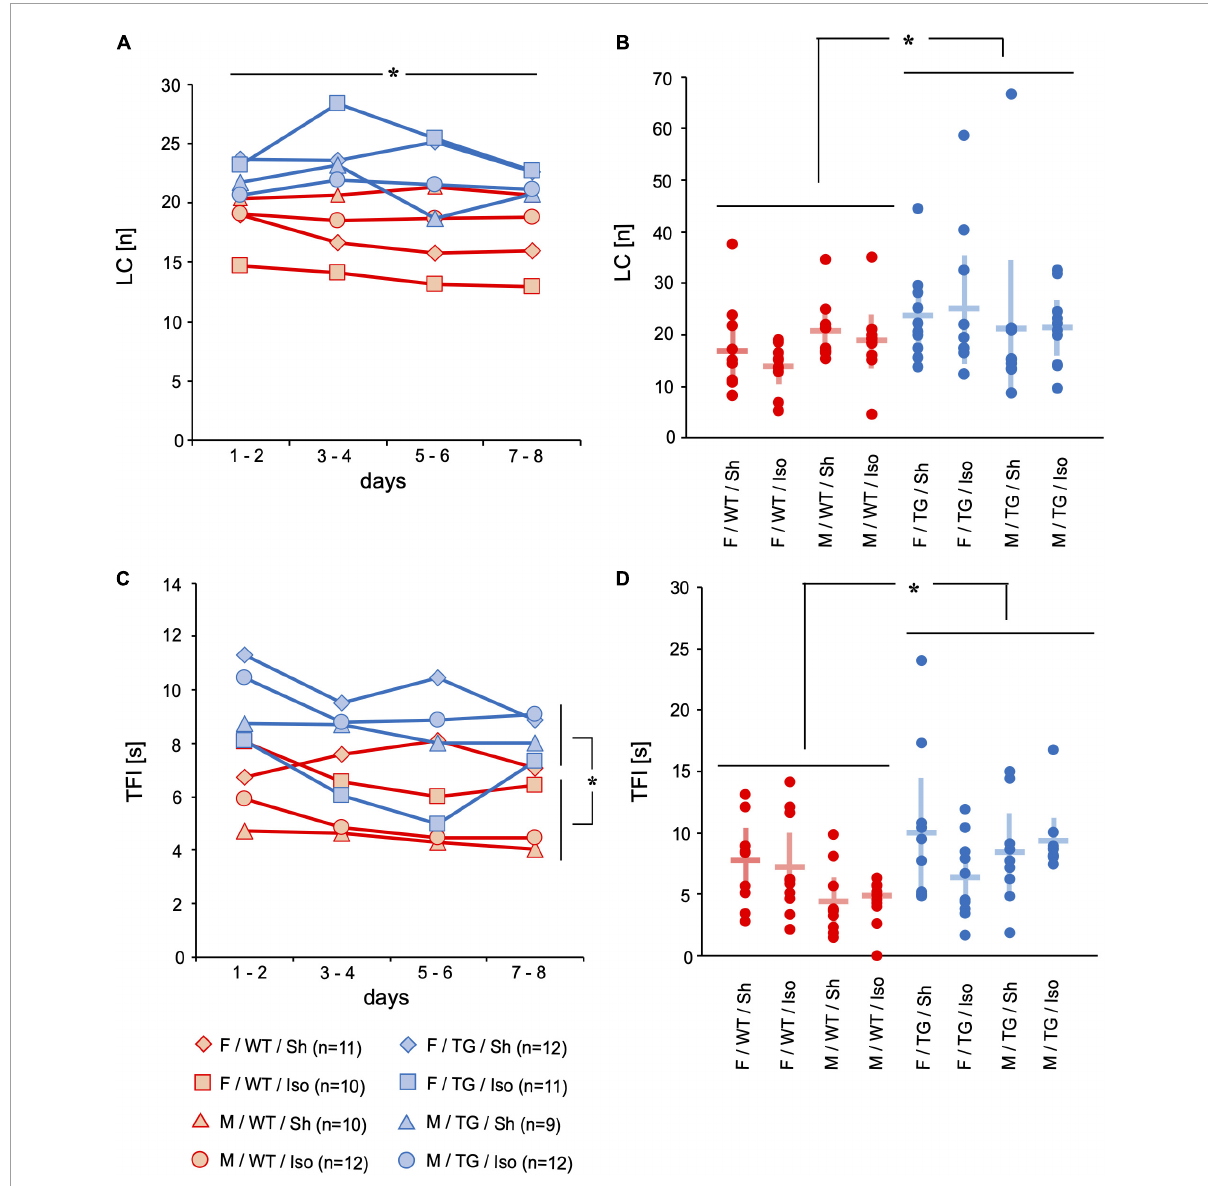
FIGURE3 Line crossings (LC) [n] and time for food intake (TFI) [s]. Mean of 4 trials per day on 2 days over time (A,C) and mean and 95%-confidence interval of 4 trials per day on all 8 consecutive days (B,D) sorted by group. LC decreased over 8 days of testing. LC were higher in Tg2576 compared to WT over all days. TFI was higher in Tg2576 compared to WT on days 7–8 and over all days. F, female; M, male; WT, wildtype (red); TG, Tg2576 (blue); Sh, sham procedure; Iso, isoflurane anesthesia. * p <